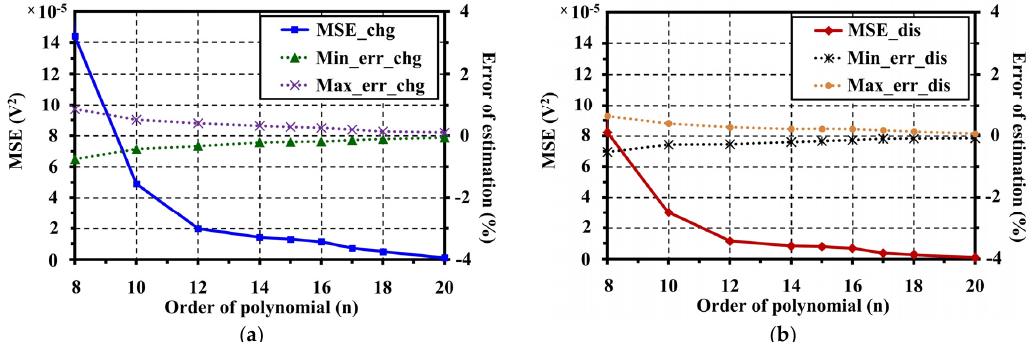
Figure 15. Comparison results of MSE s and errors of estimation at different polynomial orders: ( a ) results for charge; and ( b ) results for discharge. Table 2. Optimum state of charge ( SOC ) coefficients of the OCV model for charge and discharge.